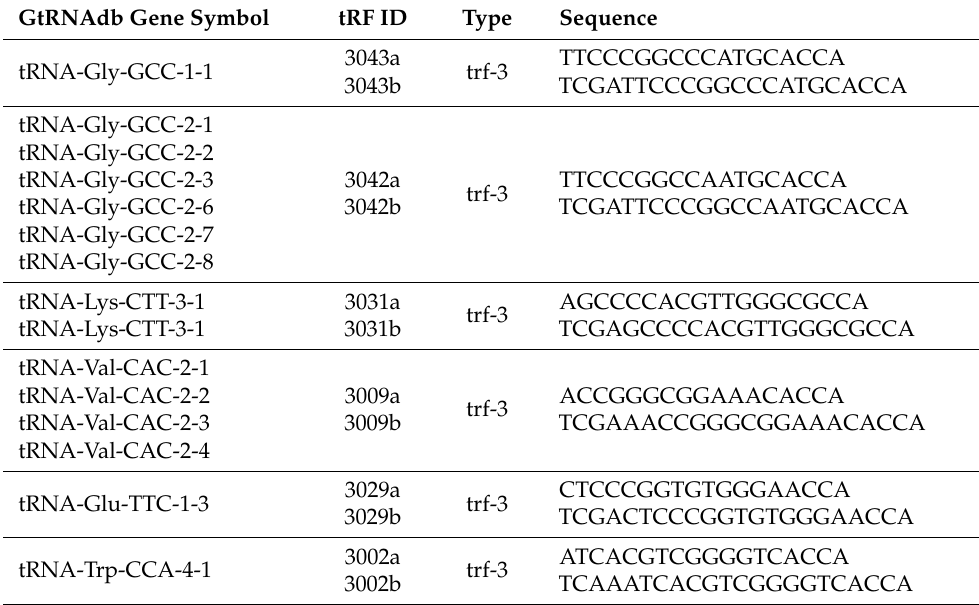
Table 5. The list of 3 ′ -tRFs.